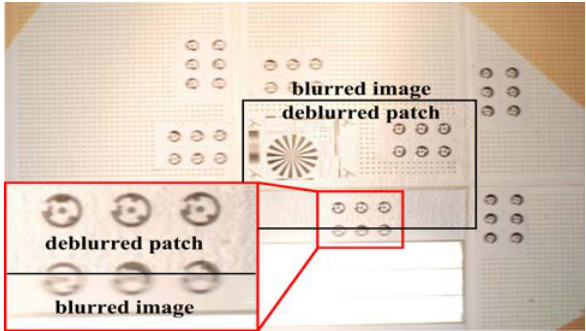
Figure 5. A deblurred patch is presented in the centre of the image. It is possible to see the photogrammetric targets are sharper and better to read and the boreholes in the ceiling panels are good to see. The inset shows a comparison between the deblurred upper part and the bottom part of a target which contains a camera displacement of 1mm and visualizes how effective the deblurring is.